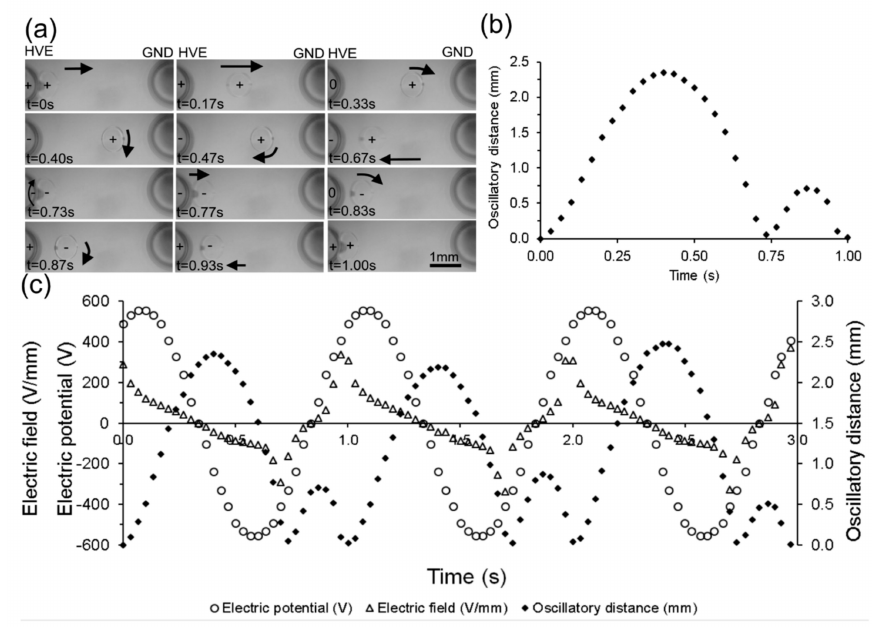
Figure 2. Droplet oscillatory motion with the high-voltage electrode under the influence of applied sinusoidal electric potential: ( a ) Sequential images of droplet motion with high-voltage electrode for one frequency cycle of applied potential of 560 V at 1 Hz; ( b ) oscillatory trip of droplet for the one frequency cycle of applied potential of 560 V at 1 Hz with the high-voltage electrode; ( c ) the droplet oscillatory motion synchronized with the applied sinusoidal voltage and electric field. Applied sinusoidal electric potential ( ), sinusoidal electric field ( ∆ ), Oscillatory distance ( ♦ (cid:35)